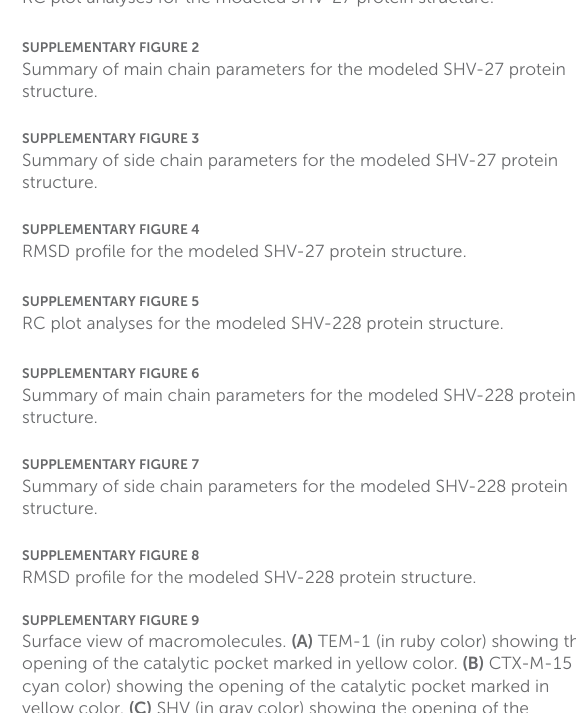
SUPPLEMENTARYFIGURE1 RC plot analyses for the modeled SHV-27 protein structure.